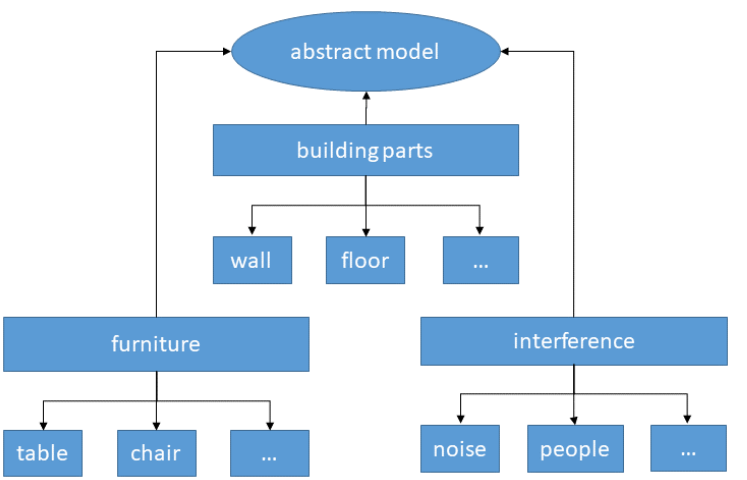
Figure 5. Hierarchical abstract model for the definition of semantic classes. The application is the classification of indoor point